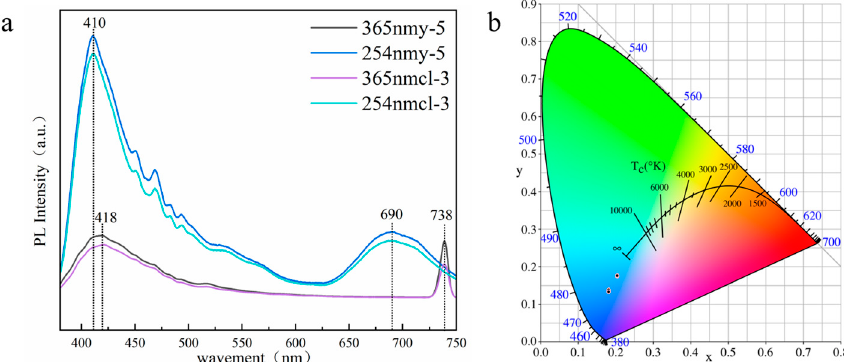
Figure 9. Fluorescence spectra of colorless, yellow scapolite ( a ) and projection on CIE1931 ( b ).